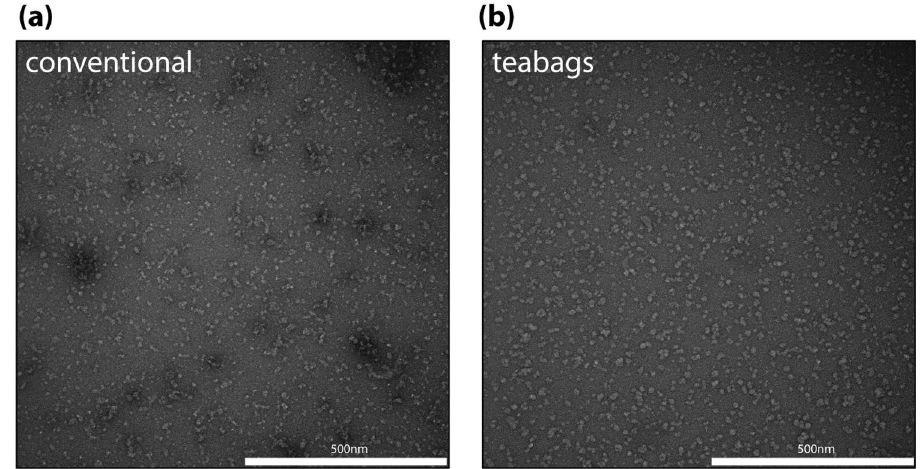
Figure 5. Quality assessment of purified ClC-1 using negative staining EM. ( a ) Conventionally purified ClC-1, showing higher degree of aggregation and increased heterogeneity in particle size and distribution; ( b ) teabag purified ClC-1, showing evenly distributed particles.